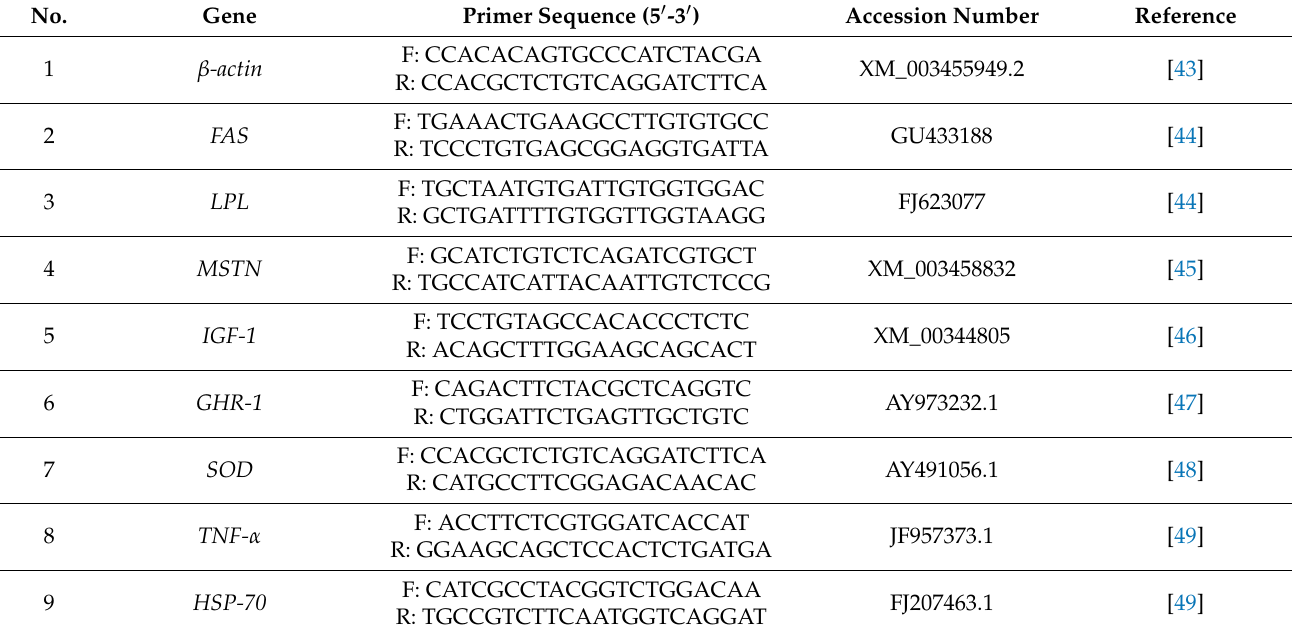
Table 2. Gene primer used for qRT-PCR amplification.